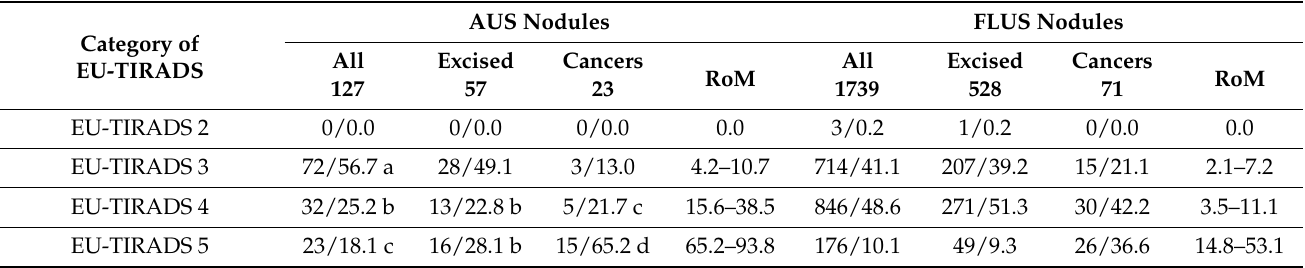
Table 2. Distribution of AUS and FLUS nodules among particular categories of EU-TIRADS and their associated risk of malignancy (RoM).